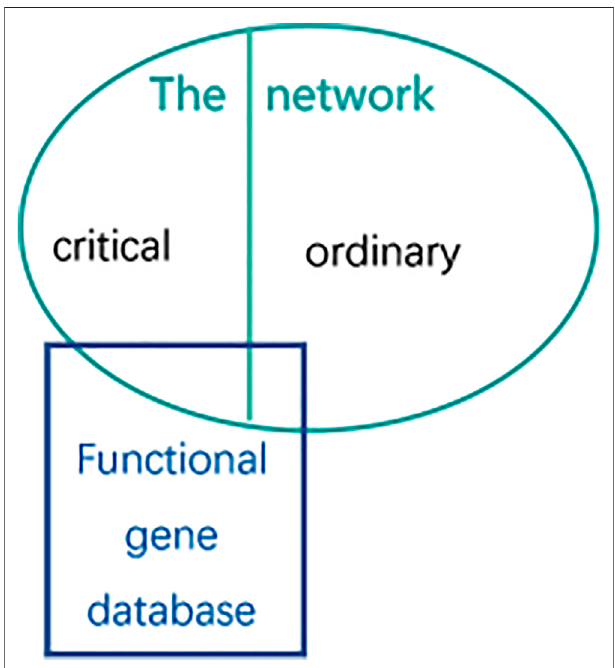
FIGURE 6 | The method of Biological enrichment analysis. The circle represents genes of the network which represents forebrain GRN, hindbrain GRN and neuron associated cells cancer related GRN respectively. And the rectangle represents the functional gene database which is on behalf of essential genes, conserved genes, cancer genes or the related genes